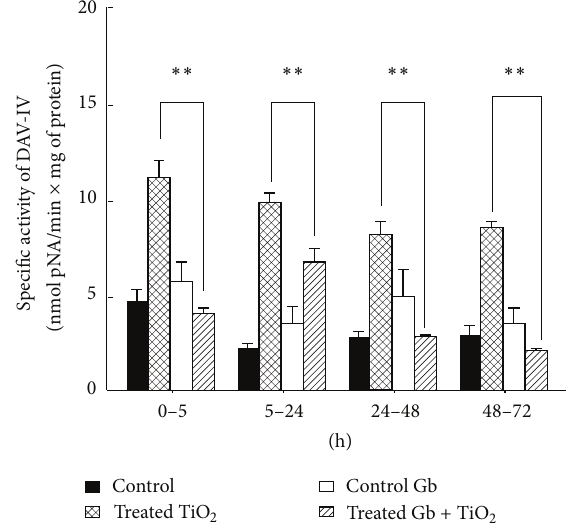
Figure 2: The effects of GbE on the renal effects of titanium dioxide on the enzymatic activity of urinary dipeptidylaminopeptidase IV, at different time periods, compared with control, GbE, and TiO 2 - treated rats. The enzymatic activity is shown as nmol p-NA/min × mg of protein. The values represent mean ± SEM, 𝑛 = 6 . The significance level is ∗∗ 𝑃 < 0.01 ; pNA: p-nitroanilide.